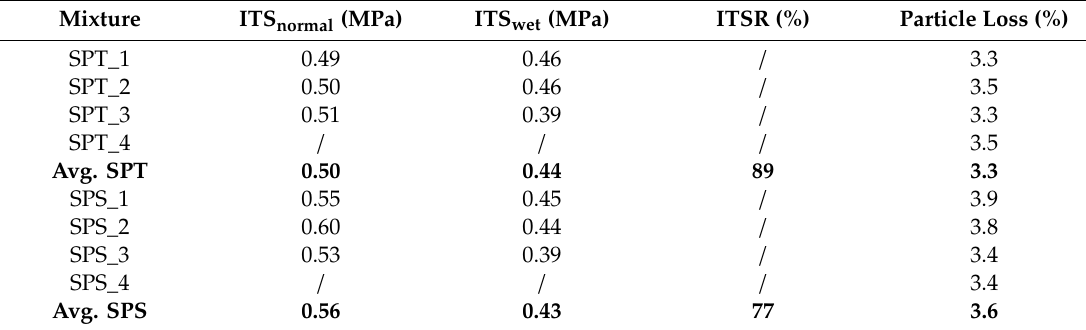
Table 6. ITSR and Cantabro test